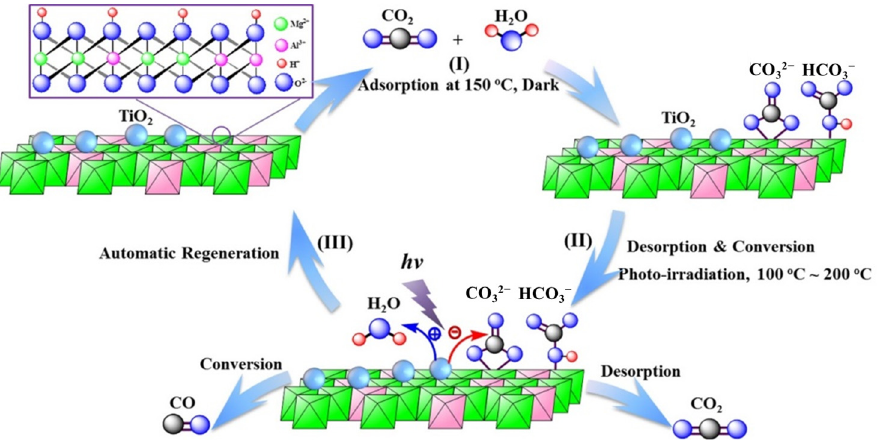
Figure 14. Schematic diagram of the integrated CO 2 capture and photocatalytic conversion over MgAl-LDO/TiO 2 [99].